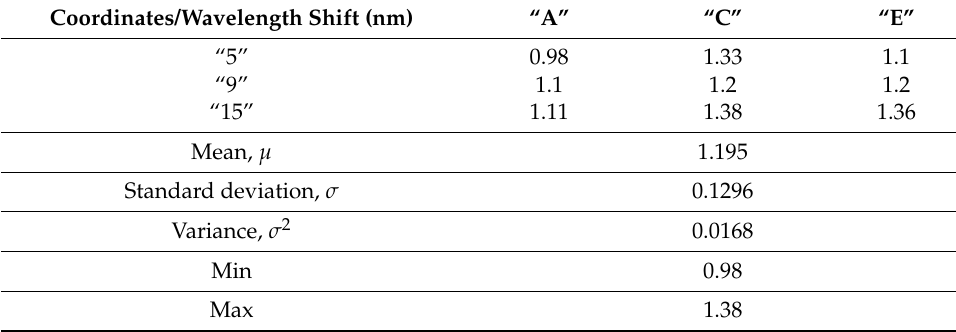
Table 2. The statistical values of the chosen points of the sensing